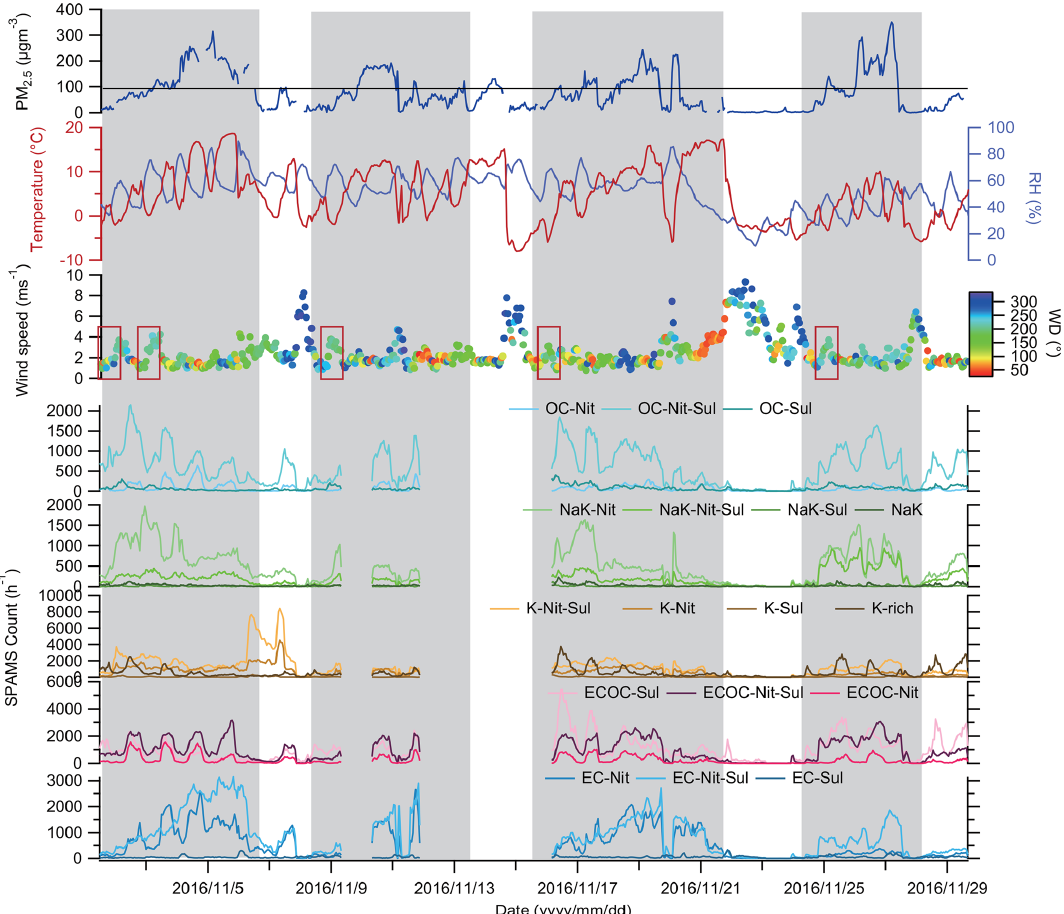
Figure 3. Time trends of PM 2 . 5 , temperature, relative humidity, wind direction, wind speed, and single-particle types at PKU. The rectangles indicate the transport of regional